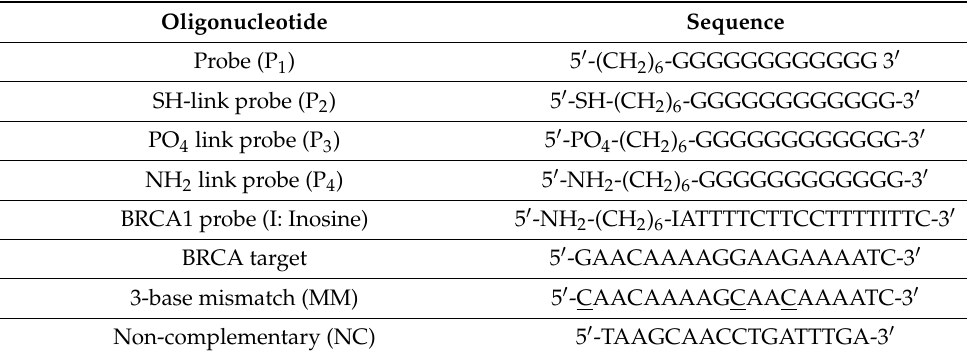
Table 1. The base sequences of all oligonucleotides.